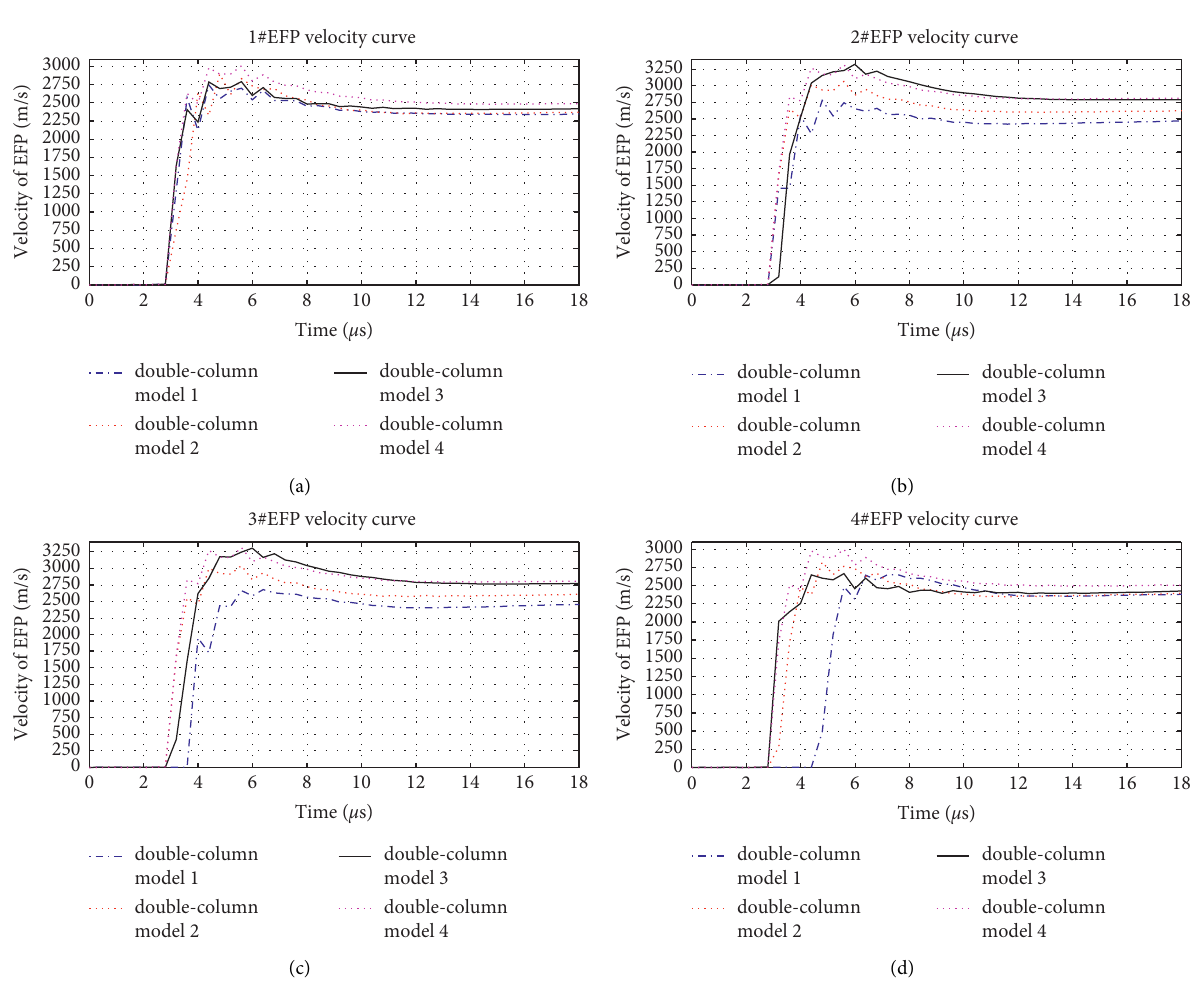
Figure 12: Comparison of forming velocity of double-column eccentric synchronous